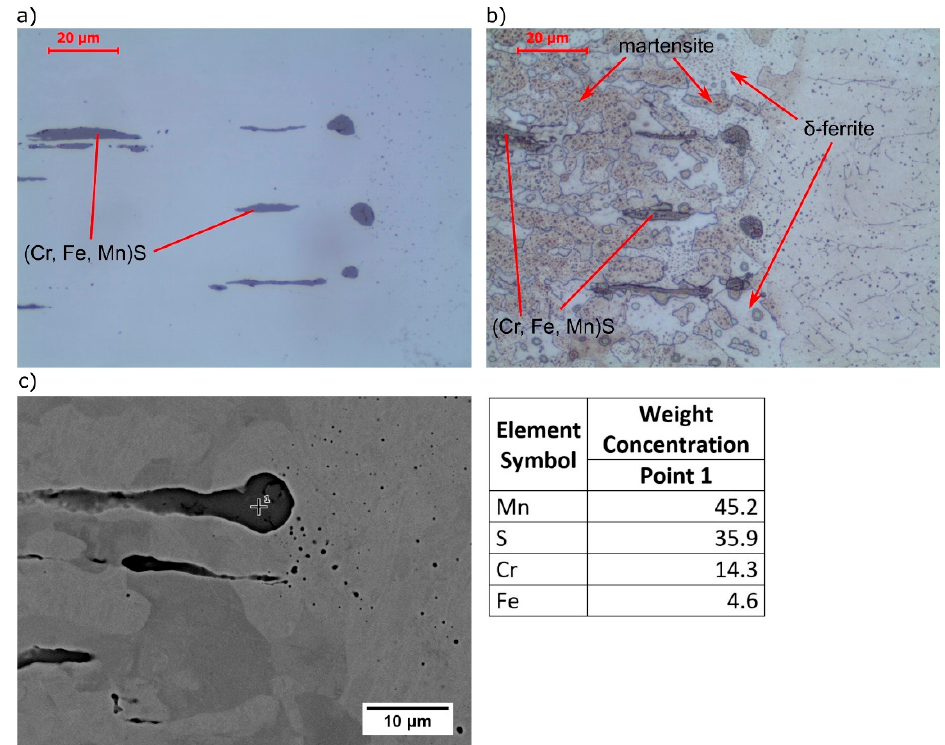
Figure 5. Microstructure near fusion line on the AISI 430F (X12CrMoS17) base metal side: ( a ) microstructure (polished), ( b ) microstructure (Kalling’s etched), ( c ) SEM microstructure and EDS point analysis (polished).